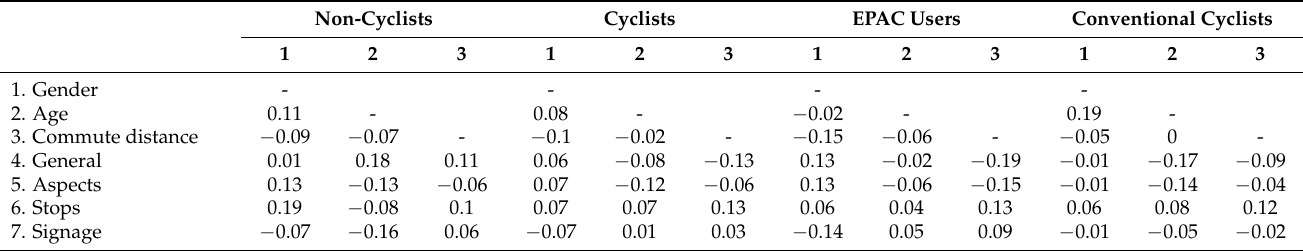
Table 5. Spearman correlations among socio-demographics and the factors for each